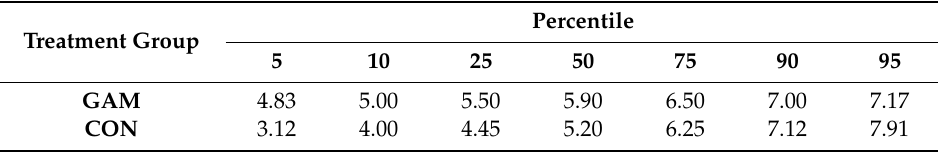
Figure 5. Box diagram of the qualifications obtained in the final exam. Note: GAM = experimental group; CON = control group. Table 7. Percentiles of qualifications in final exam (GAM vs. CON).